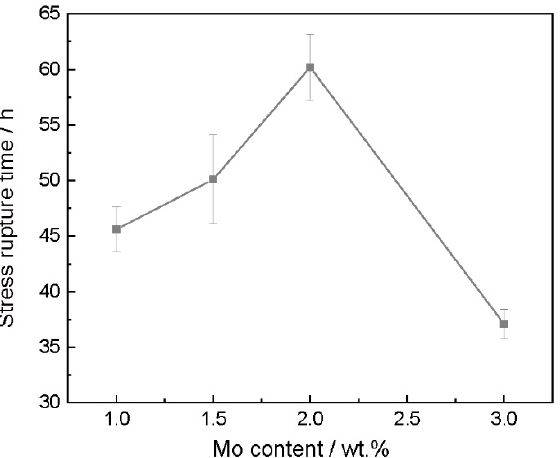
Figure 9. The stress rupture life of the alloys with different Mo content at 975 °C/225 MPa.